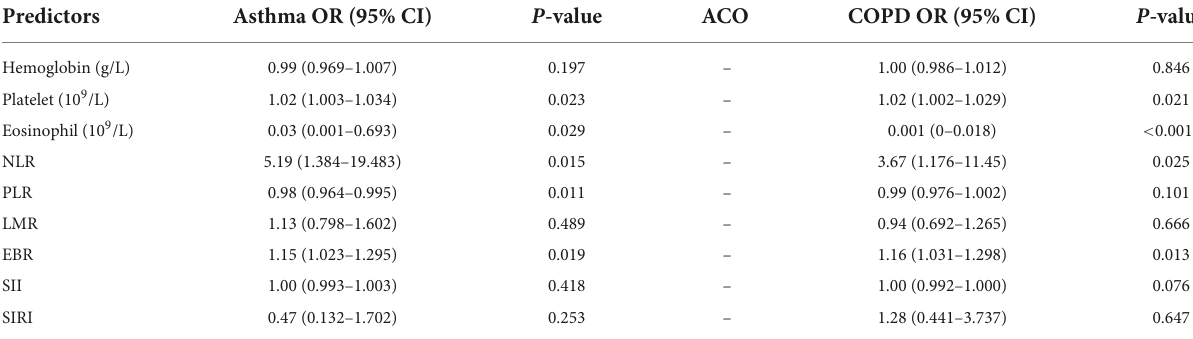
TABLE 3 Multinomial logistic regression analysis for asthma, ACO, and COPD.